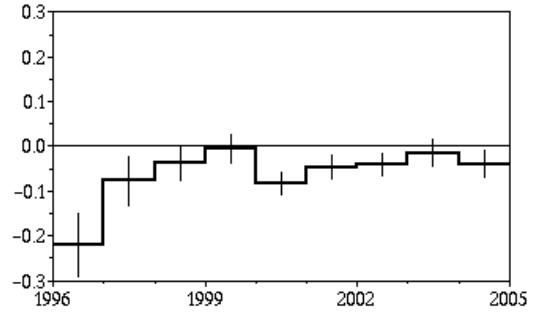
Fig. 3. East-west asymmetry in CME, calculated for consecutive years of SOHO LASCO observations. The values for 1998 and 1999 are based on the incomplete data (see the caption of Fig. 1). So, they may differ, to some degree, from the actual ones, consider- ing seasonal variability (see Fig. 4). The horizontal thin line marks the zero asymmetry level. The error bars represent 1 σ statistical errors.